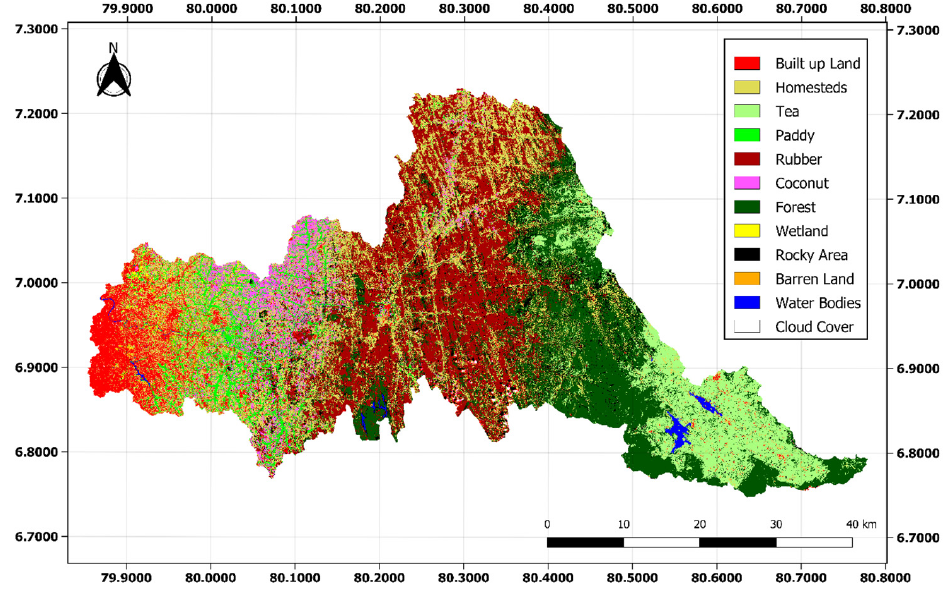
Figure 1. Land use pattern in the Kelani River basin.